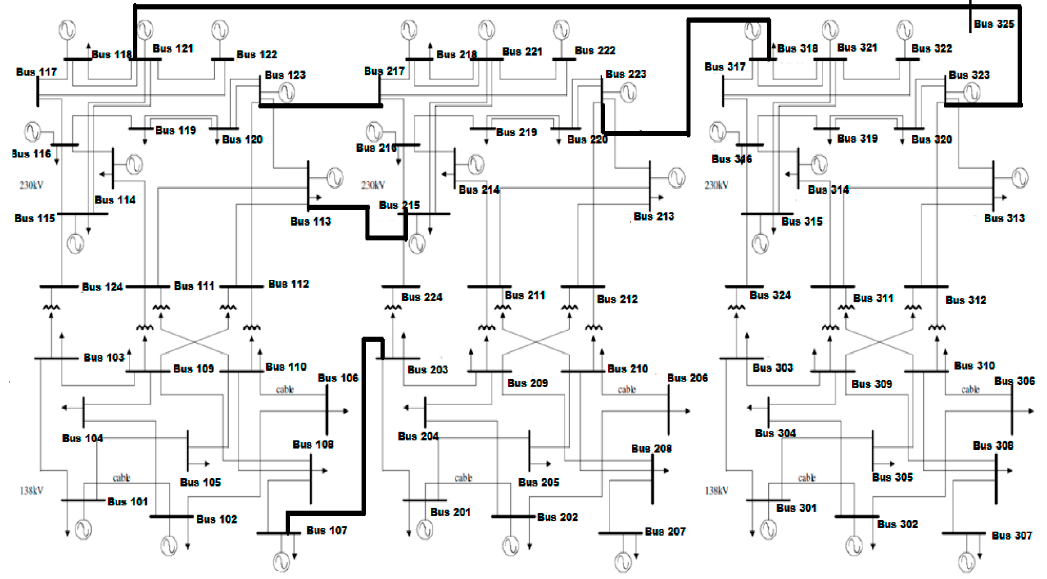
Figure 2. The electrical system IEEE RTS-96. 189